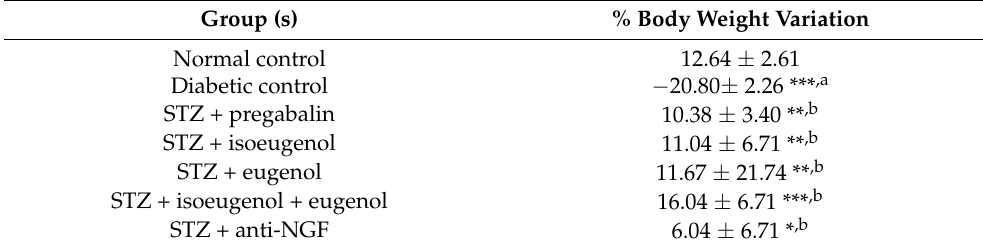
Figure 2. Effect of isoeugenol, eugenol, and their combination on changes in the body weight of experimental rats. A p < value of 0.05 was considered statistically significant. Significance is represented as * p < 0.05, ** p < 0.01; a—normal control versus diabetic control corresponding to the same day, b—diabetic control versus treatment groups corresponding to same day. Table 1. Effect of isoeugenol, eugenol, and their combination on % body weight variation.